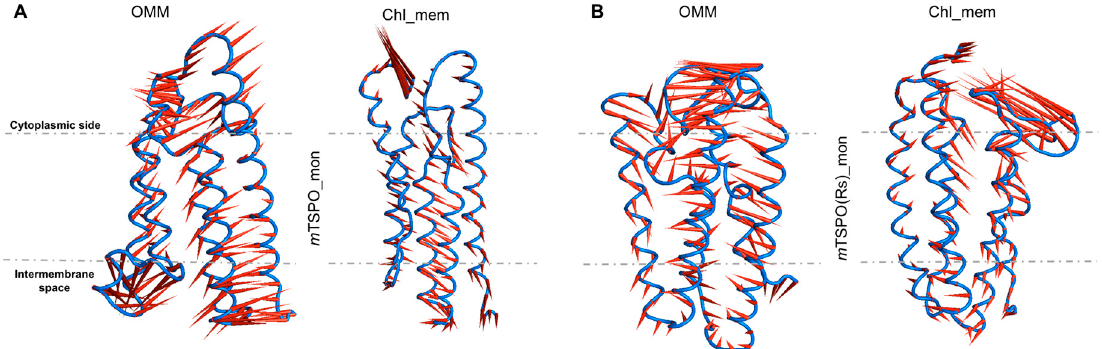
Figure 7. Porcupine plots depicting prominent motions averaged across the first normal mode for ( A ) m TSPO_mon and for ( B ) m TSPO(Rs)_mon, in both OMM and chl_mem. A dotted line marks the approximate location of the membrane. Longer spines indicate the region with higher fluctuations for the first normal mode. These correspond to the cytoplasmic loops. The analysis was performed on the equilibrated part of the trajectory. The second normal mode is reported in Figure S8.